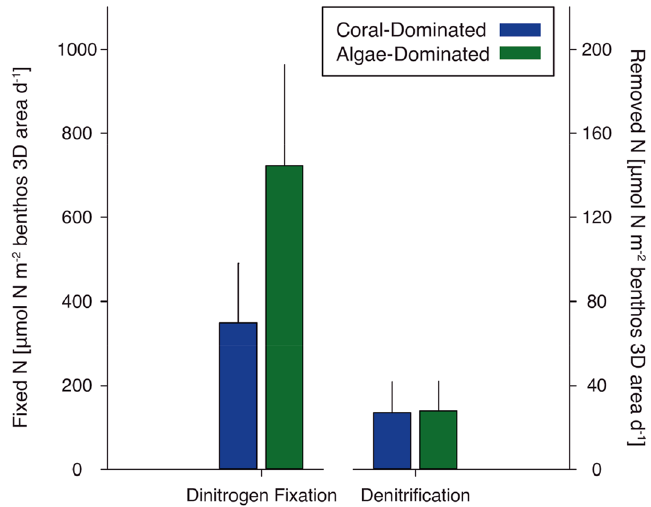
Figure 3. Total fixed (via dinitrogen fixation) and removed N (via denitrification) in both reef areas (calculated as sum of means of extrapolated rates of individual benthic categories ± standard propagated error; according to supplementary material SM3; no significant differences were observed by applying Friedman’s aligned rank test).